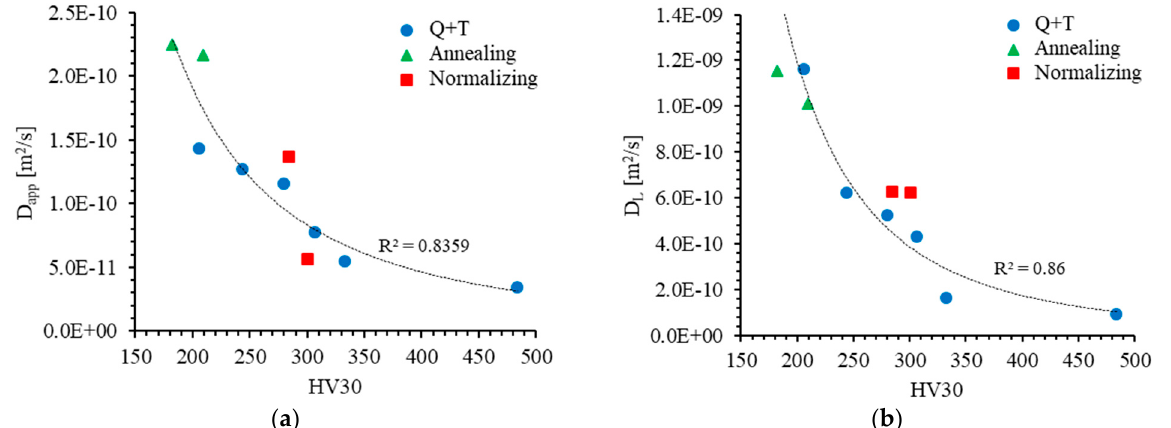
Figure 9. Relationship between hydrogen diffusivity and steel hardness. ( a ) D app of the first transient vs. HV30 and ( b ) D L vs. HV30.